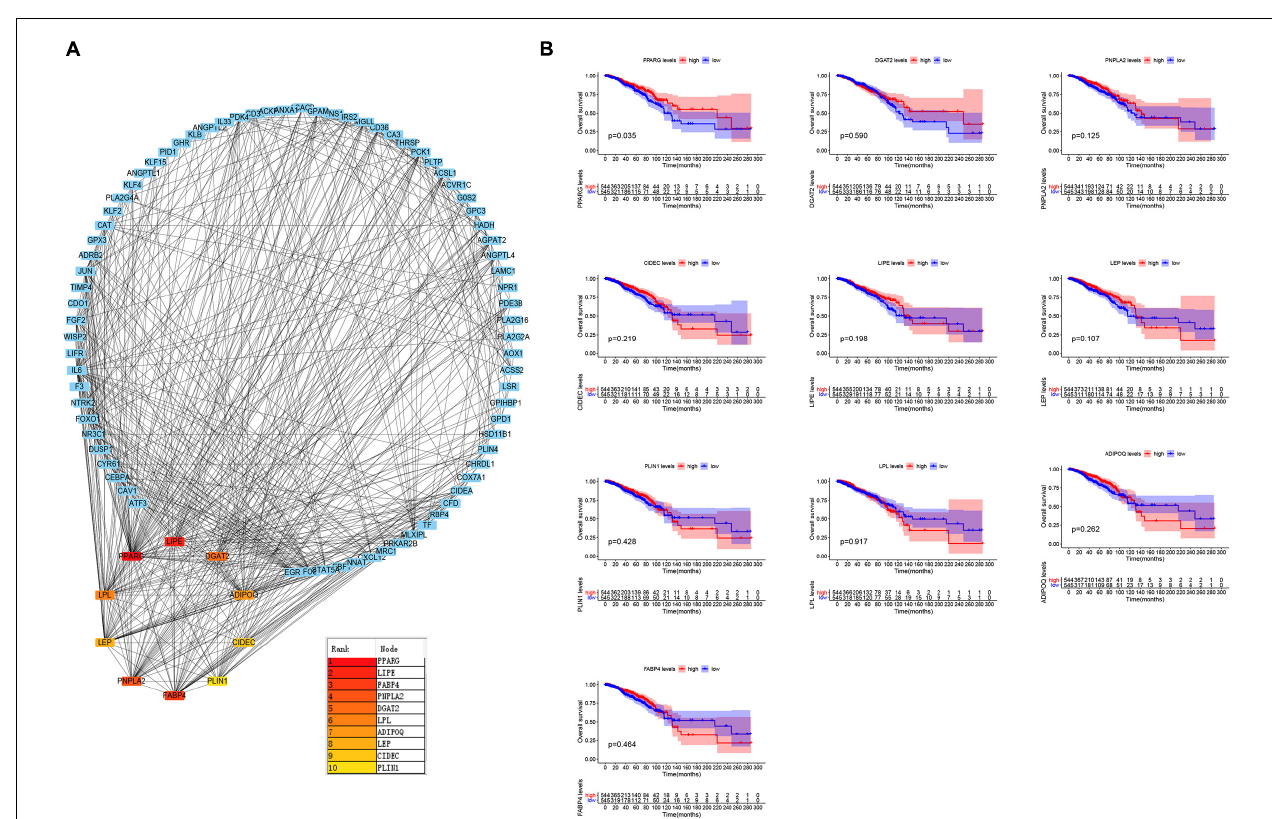
FIGURE 2 | Identification of the key genes. (A) Protein-Protein Interaction network analysis and prediction of its core genes. (B) Kaplan–Meier survival curves were generated for selected 10 genes extracted from the comparison of groups of high (red line) and low (blue line) gene expression.